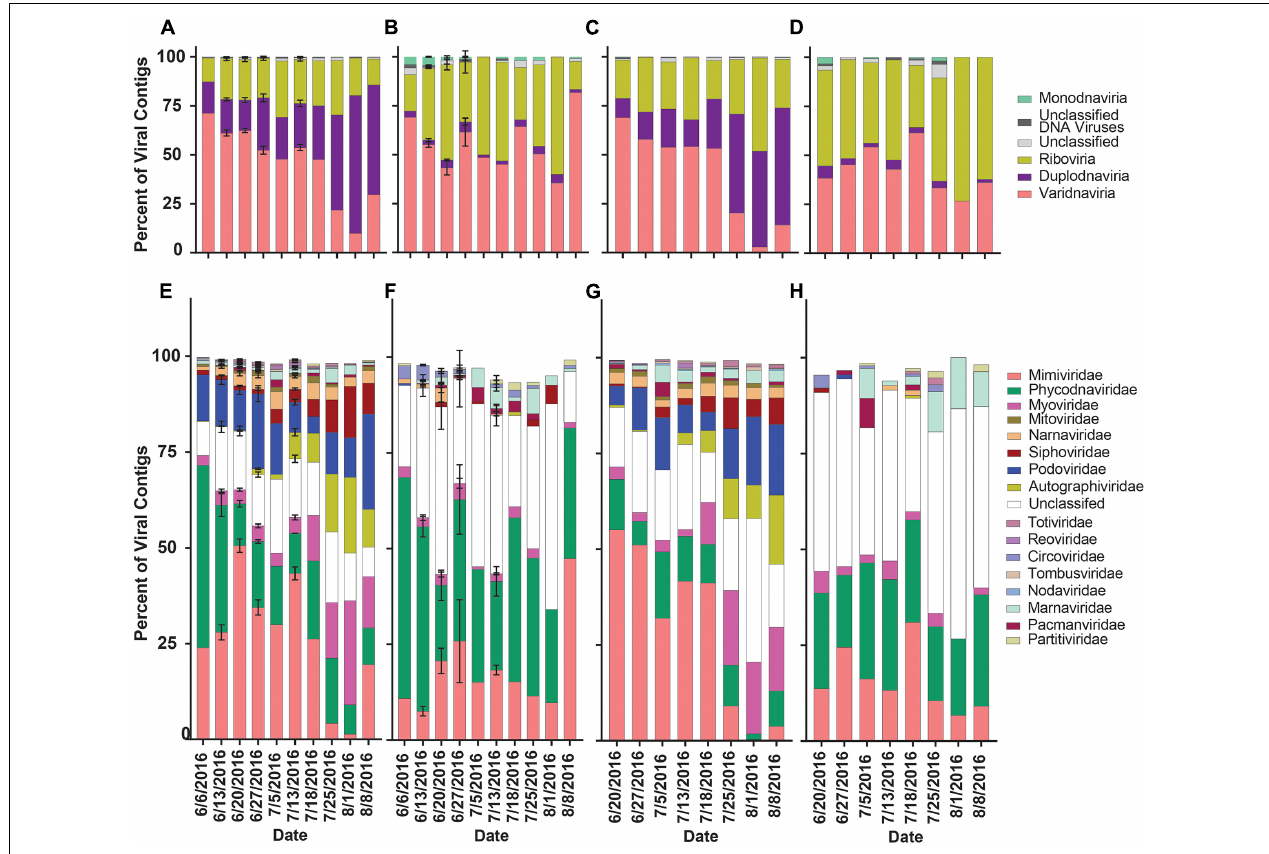
FIGURE 5 | Relative proportion of viral contigs by phylogeny, date and sampling location. Proportions of viral contigs from (A) rRNA-reduced and (B) poly-A selected Quantuck Bay libraries grouped by realm. Proportions of viral contigs from (C) rRNA-reduced and (D) poly-A selected Tiana Beach libraries grouped by realm. Proportions of viral contigs from (E) rRNA-reduced and (F) poly-A selected Quantuck Bay libraries grouped by family. Proportions of viral contigs from (G) rRNA-reduced and (H) poly-A selected Tiana Beach libraries grouped by family. On dates where multiple samples exist, standard deviation is shown by error bars.